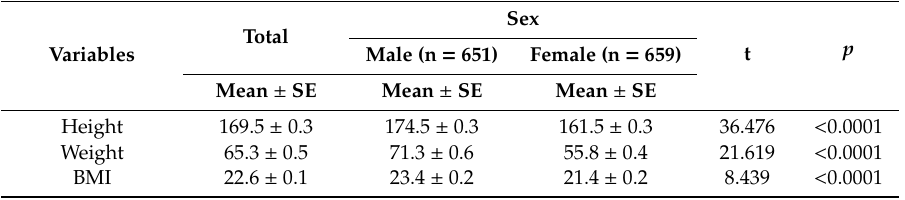
Table 2. Distribution of means for anthropometric and biomarker (n =